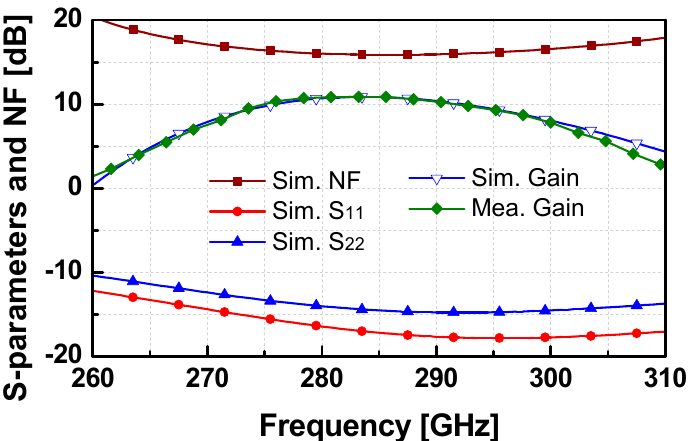
Figure 13. Simulation results of S-parameters and noise figure (NF) and measured gain of the amplifier.